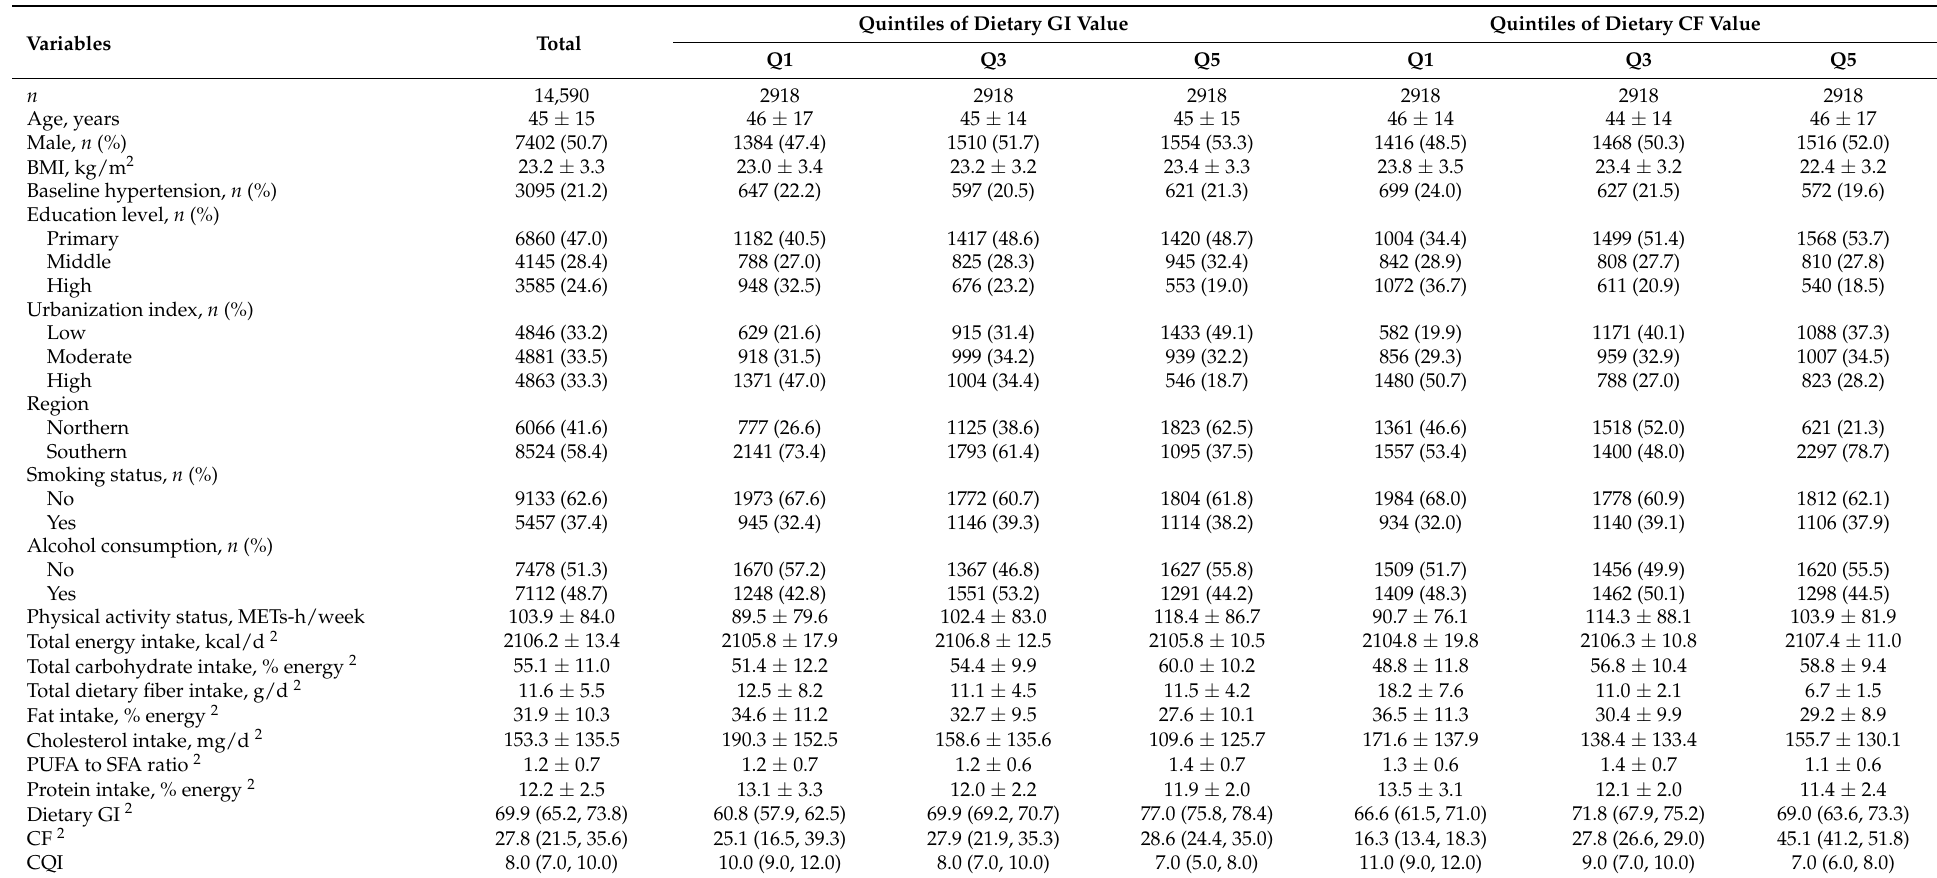
Table 1. Baseline sociodemographic, anthropometric and lifestyle characteristics of participants were presented according to quintiles of dietary GI and CF values in 14,590 Chinese adults of the China Health and Nutrition Survey 1997–2015 1